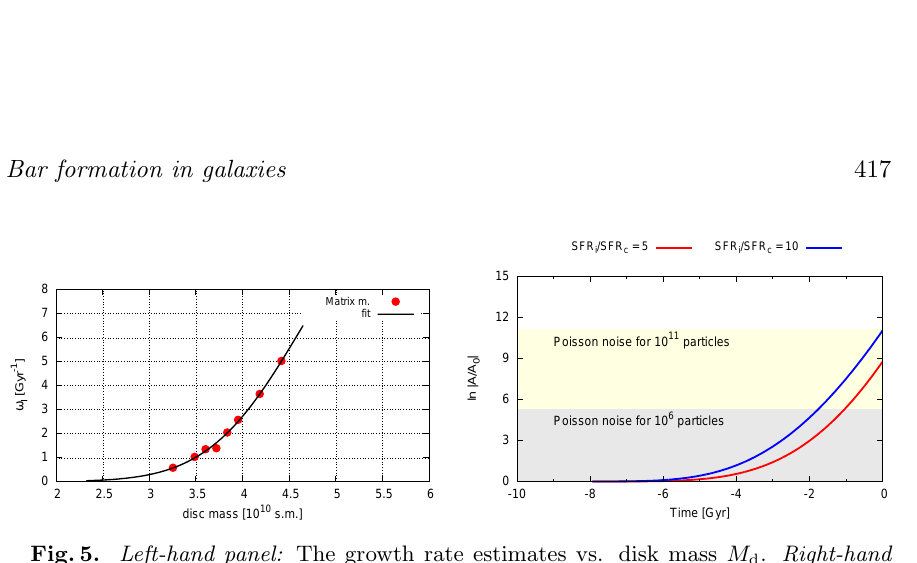
Fig. 5. Left-hand panel: The growth rate estimates vs. disk mass M d . Right-hand panel: Amplification of the initial perturbation taking into account the growth of the disk mass according to adopted SFR profiles (see main